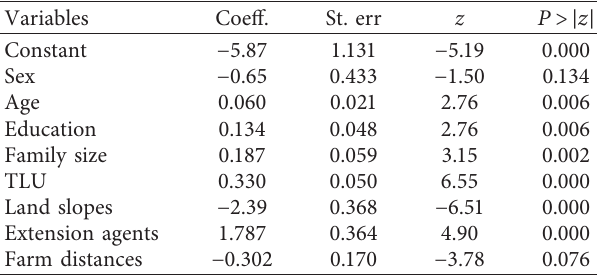
Table 6: Distribution of sampled household